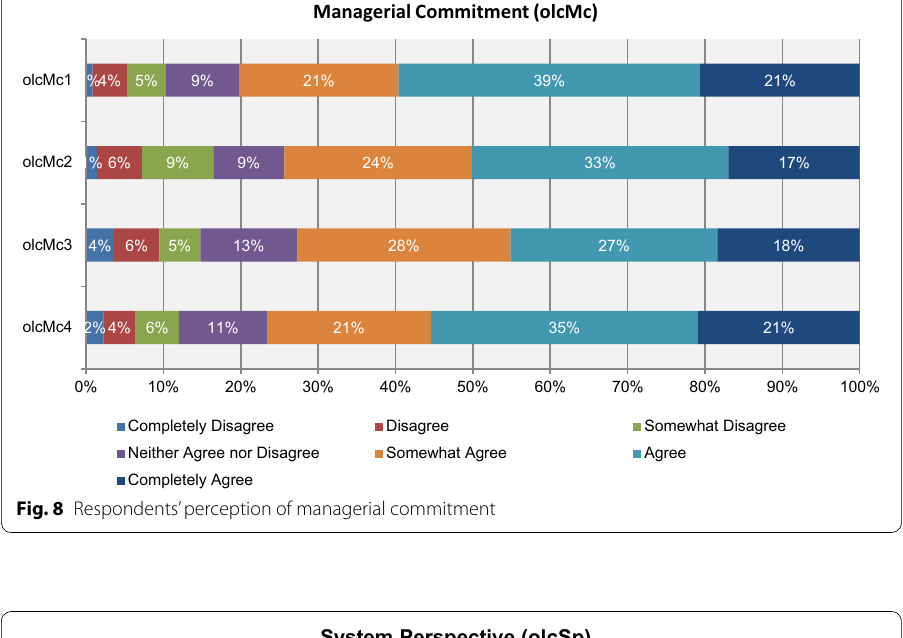
Fig. 8 Respondents’ perception of managerial commitment